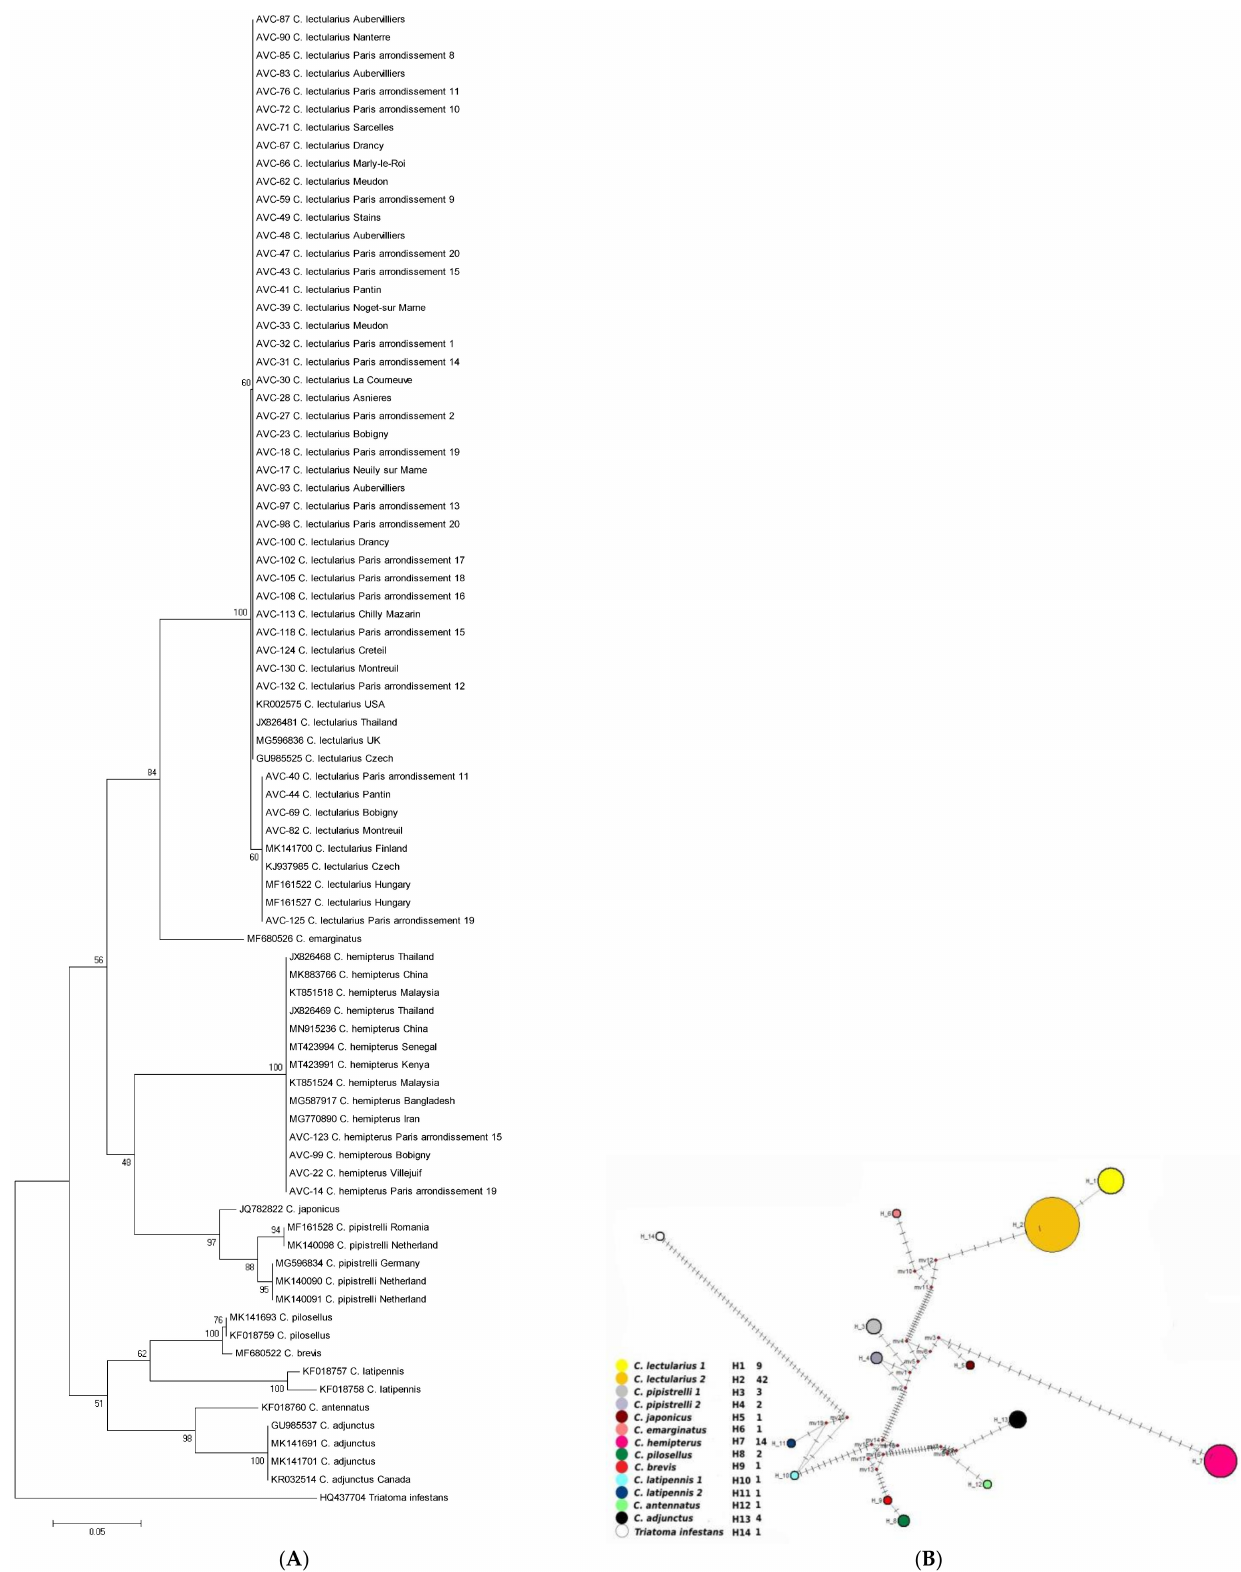
Figure 2. ( A ) Neighbor-joining (NJ) tree reconstructed from COI sequences of bed bug specimens collected in the present study (beginning with AVC) and from sequences collected from GenBank. ( B ) Global analysis median-joining network for various Cimex populations. Circle size and circle color indicate frequency and geographical location of haplotypes, respectively. Haplotype numbers are written next to the corresponding